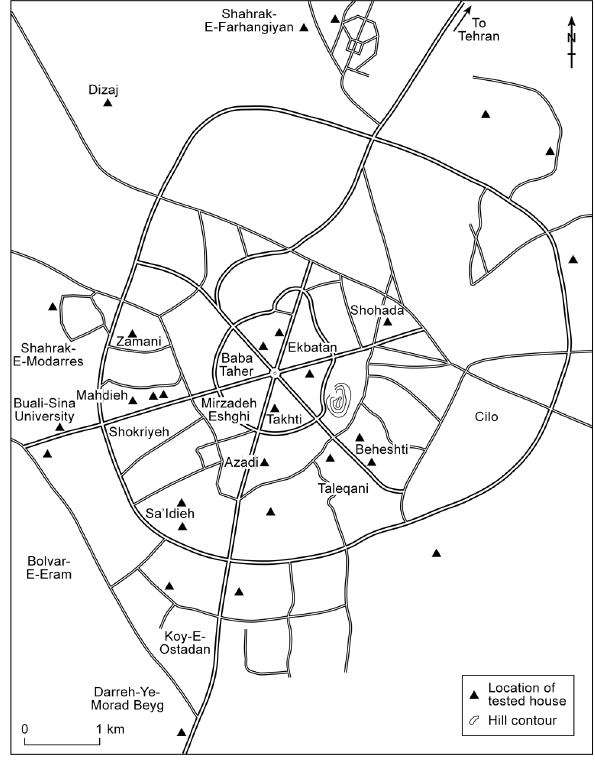
Figure 2. Plan view of the street layout of Hamadan showing districts together with the location of indoor radon measurement sites.